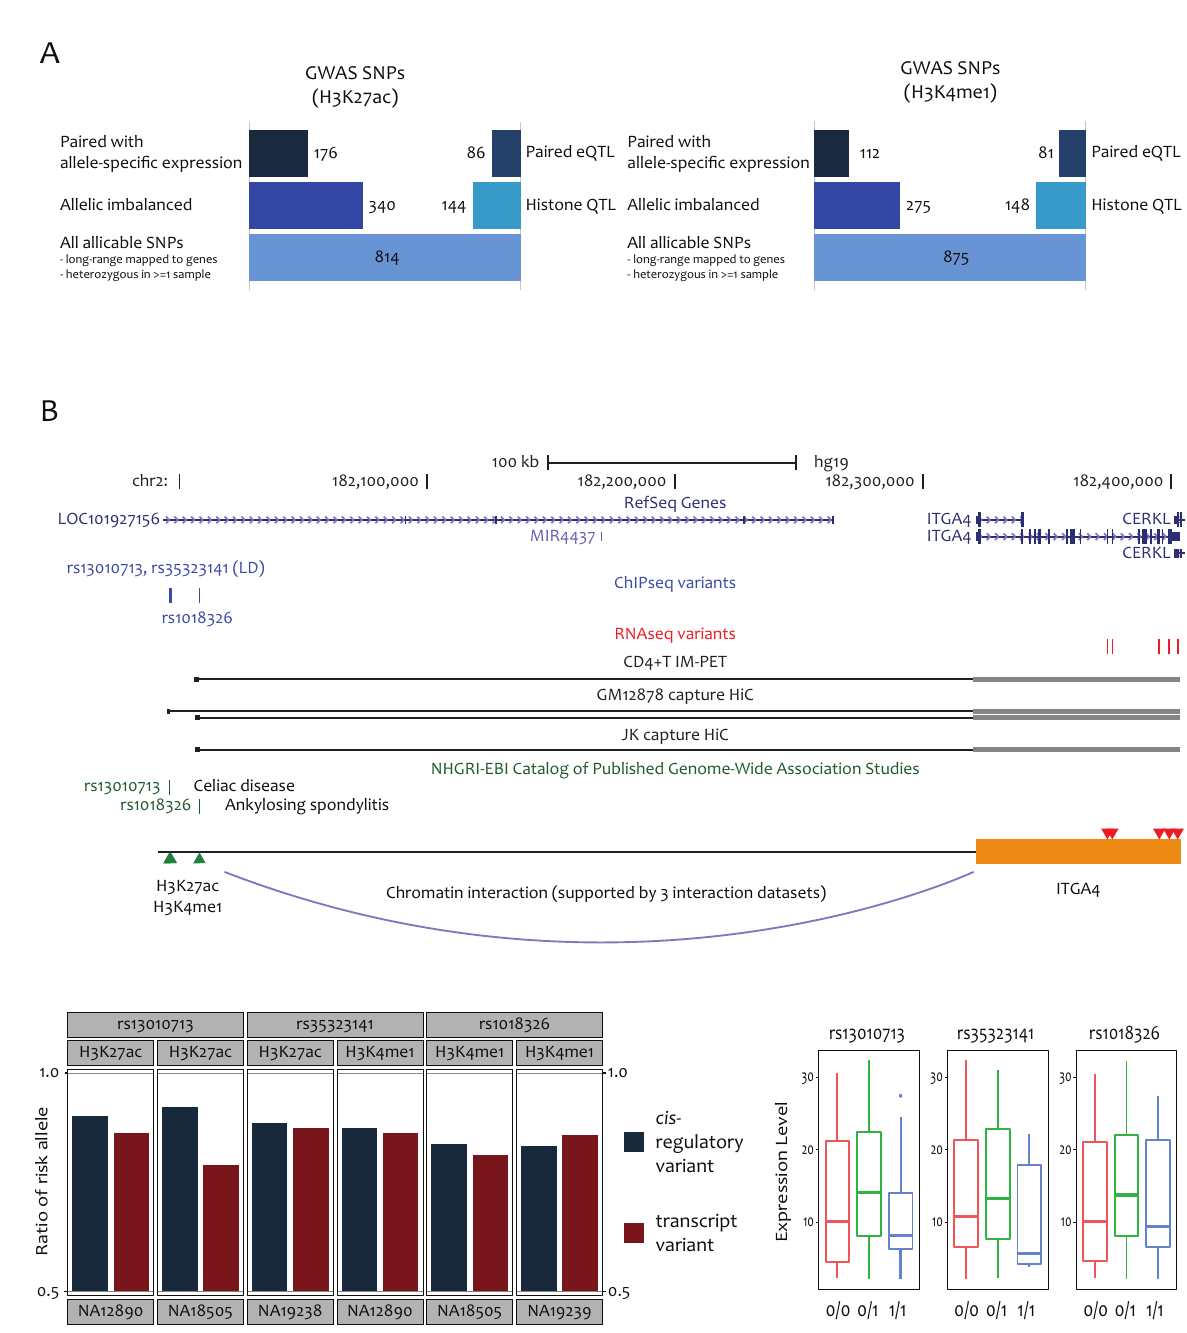
Fig 2. (A) Comparisonof sensitivity betweenallelicmappingversus eQTL mapping.The number of GWAS SNPs with ChIP-seq imbalance versus that of GWAS SNPs that are histone QTLs (middlerow), and the numberof the imbalancedGWAS SNPs with paired allele-specific expressionversus that of the histone QTLs that are eQTLs for pairedgenes(top row). For both allelicmappingand eQTL mapping, an unadjustedP < 0.05 was used as a threshold.(B) Allelicmappingfor ITGA4. Three SNPs (blue)showedalleleimbalancein ChIP-seqreads (bluebar graphs)with biastowardsthe diseaserisk allele.These SNPs were connected to ITGA4 as indicated by three differentchromatininteractomedatasets (black lines).The RNA-seqvariants(red) showedallele-specific expression(red bar graphs)in the same directionas the ChIP-seq variants. eQTL mappingfailedto detect association (boxplots).